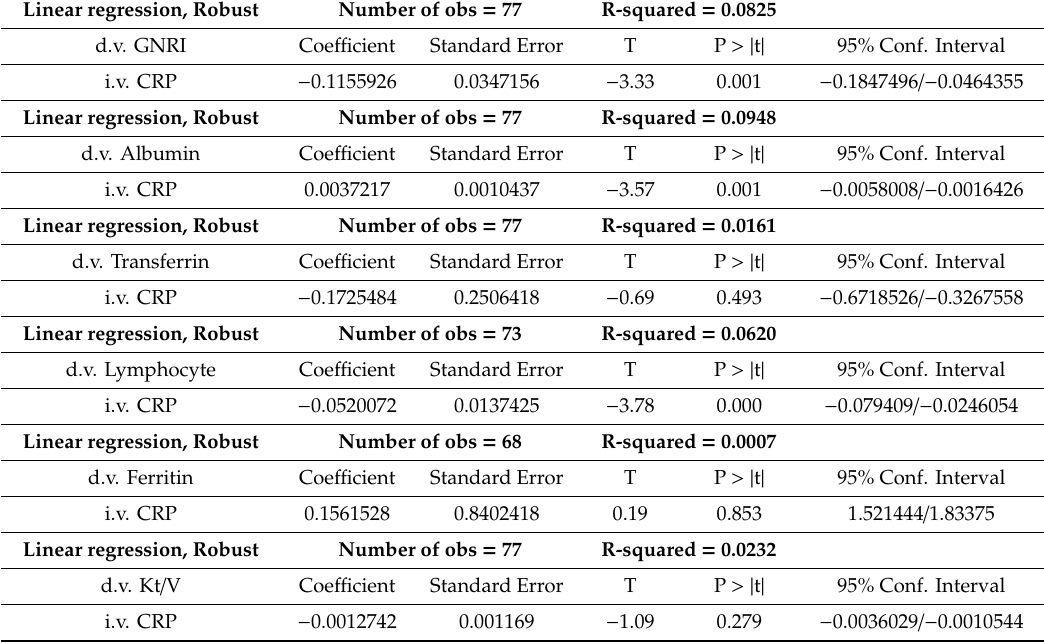
Legend to Table 3. Significant predictions are represented in bold; d.v., dependent variable; i.v., independent variable. The low R-squared in the presence of significance shows that even noisy, high-variability data can have a